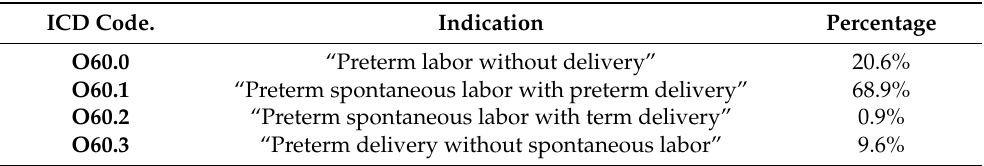
Table 1. Percentage of preterm labor and delivery hospital admission. ICD Code. Indication Percentage O60.0 “Preterm labor without delivery” 20.6% O60.1 “Preterm spontaneous labor with preterm delivery” 68.9% O60.2 “Preterm spontaneous labor with term delivery” 0.9% O60.3 “Preterm delivery without spontaneous